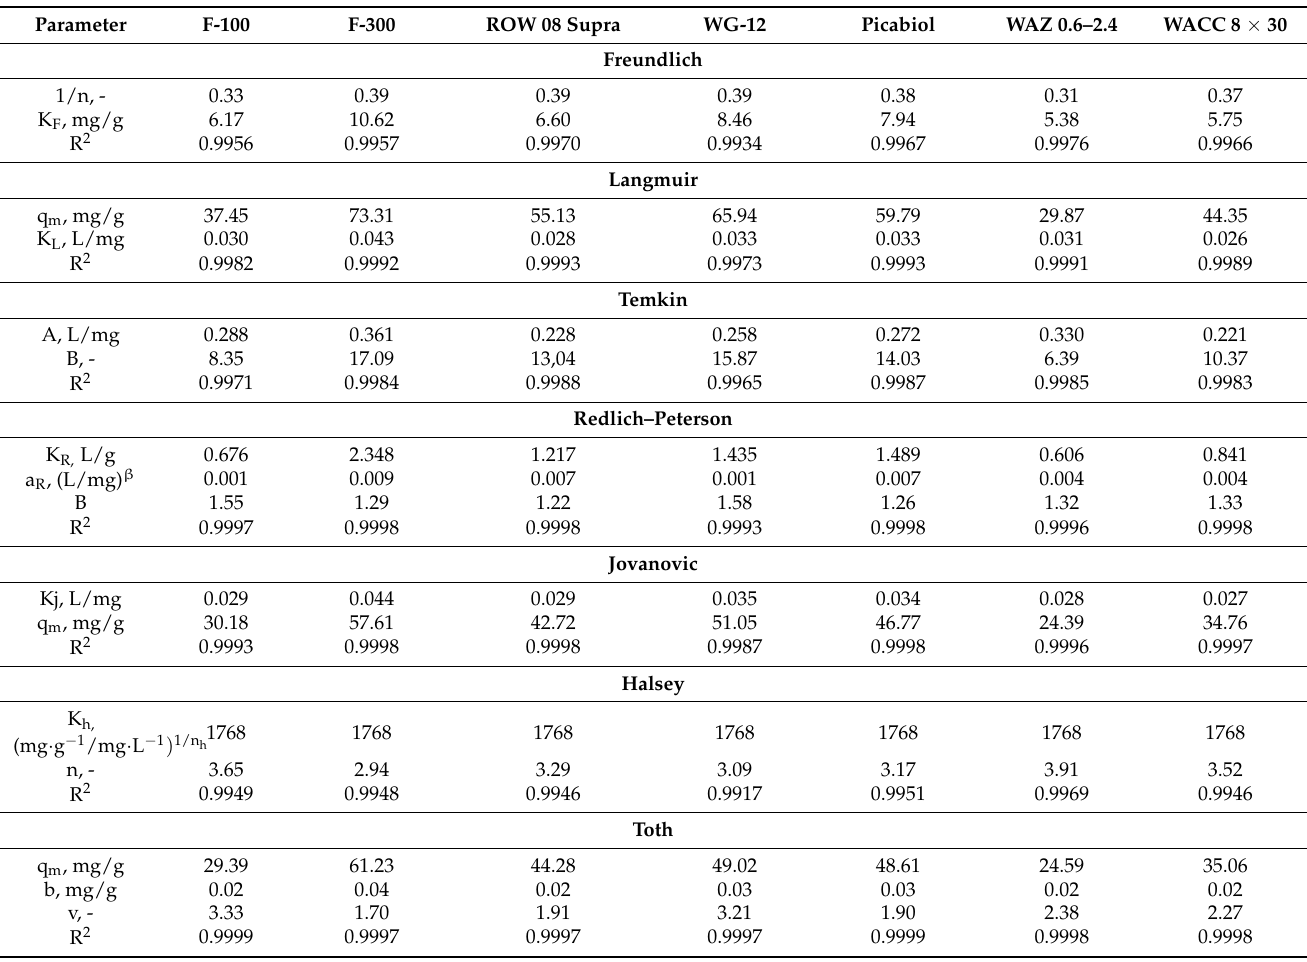
Table 7. Constants of oxytetracycline adsorption isotherms on commercial activated